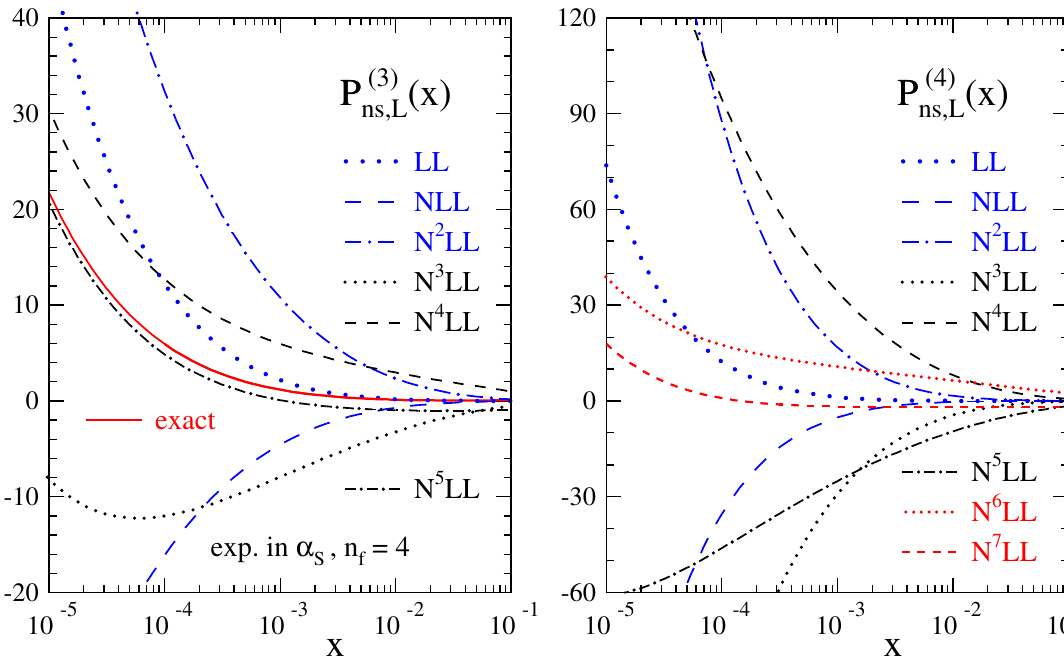
Figure 1 . Successive small- x approximations to the N n LO four-flavour splitting functions P ( n ) in the large- n c limit for n = 3 (left), compared to the exact result, and n = 4 (right). The respective N 5 LL and N 7 LL curves include all terms with x 0 ln k x at k > 0 as specified by eqs. (3.3), (3.4) and